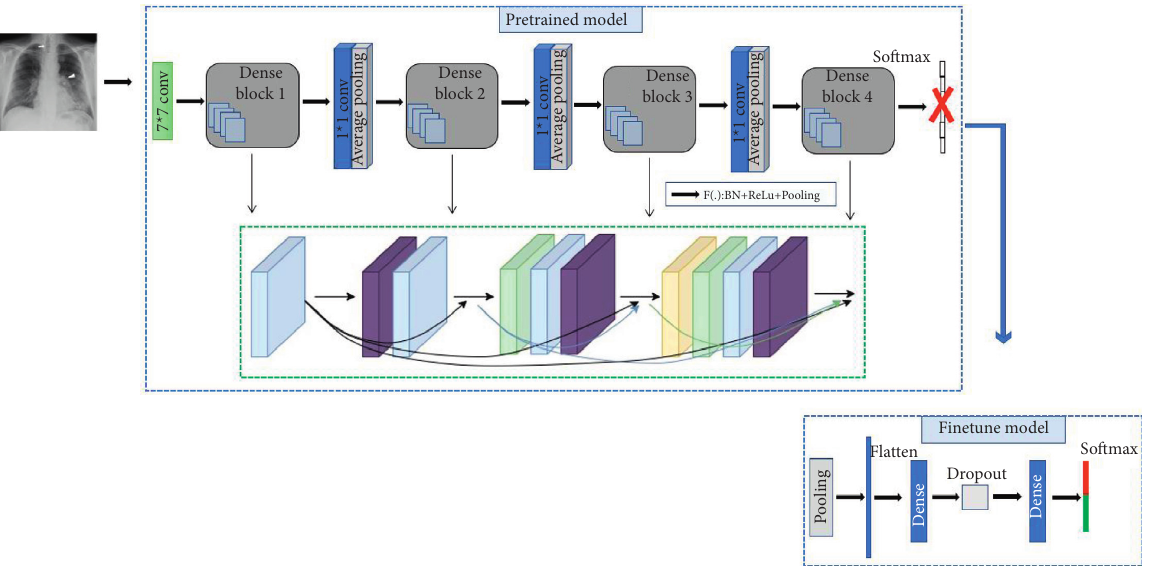
Figure 2: Architecture of the proposed fine-tune DenseNet121 pretrained